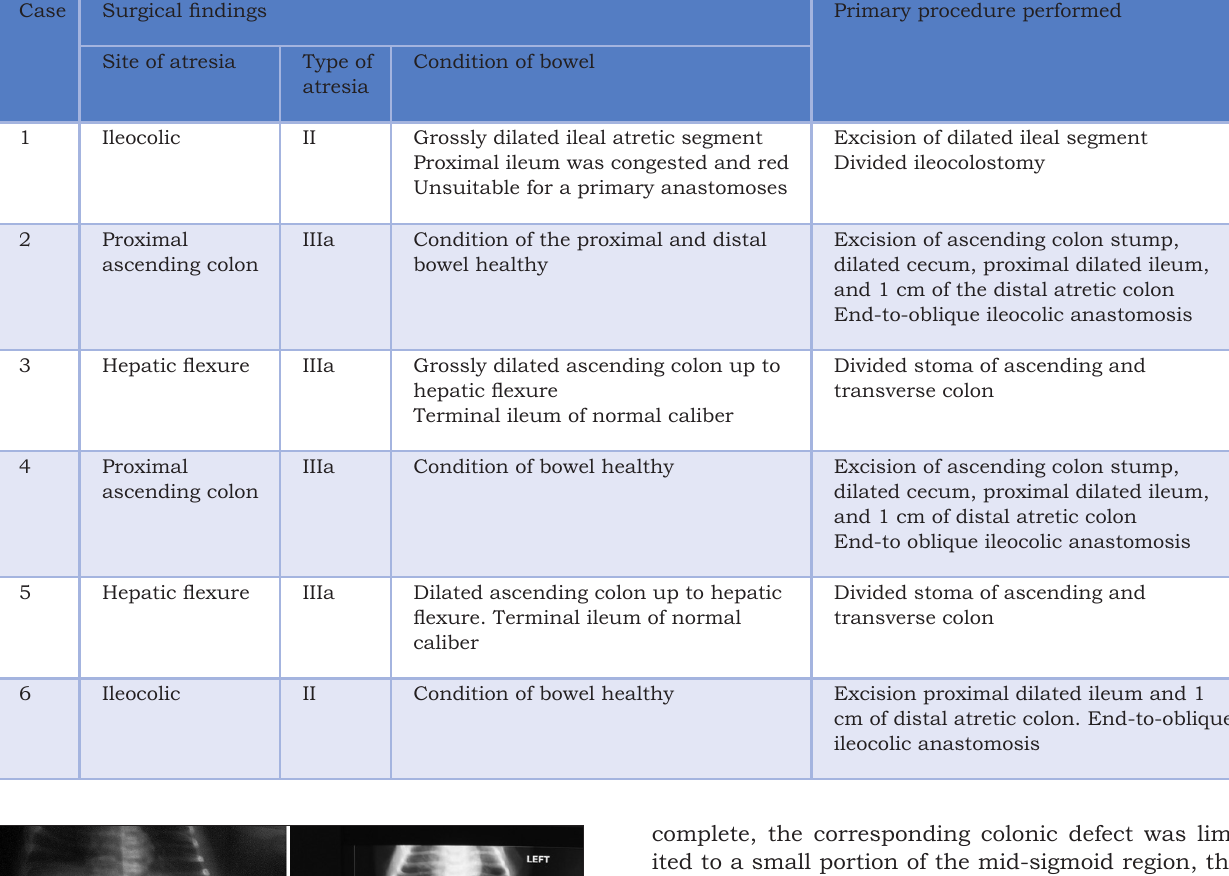
Table 2: Presentation and management of the six cases operated following a contrast enema Case